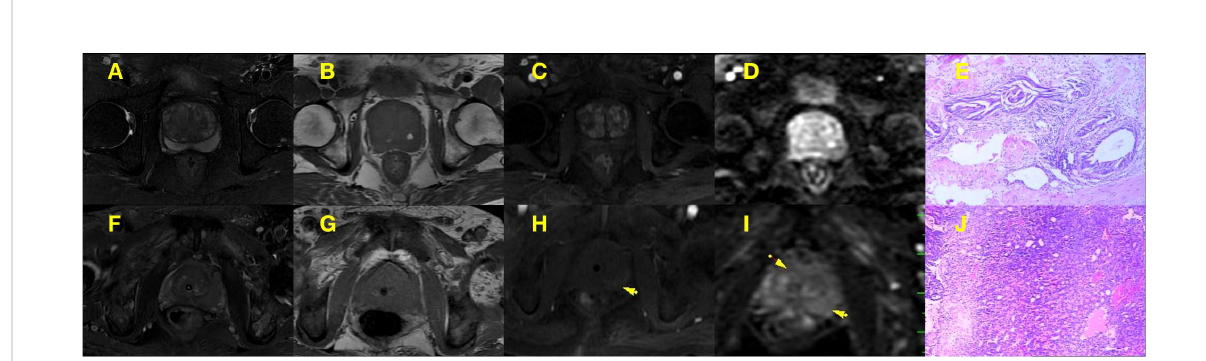
patients, with AUCs of 0.705 for K trans , 0.700 for K ep , 0.737 for V p ,